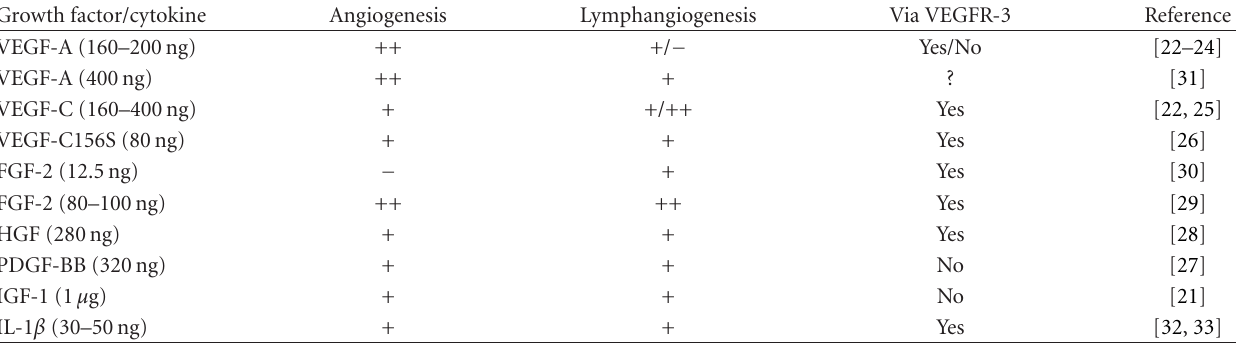
Table 1: Growth factors and cytokines in corneal lymphangiogenesis assay. Various growth factors or cytokines induce lymphangiogenesis as well as angiogenesis with or without VEGFR-3